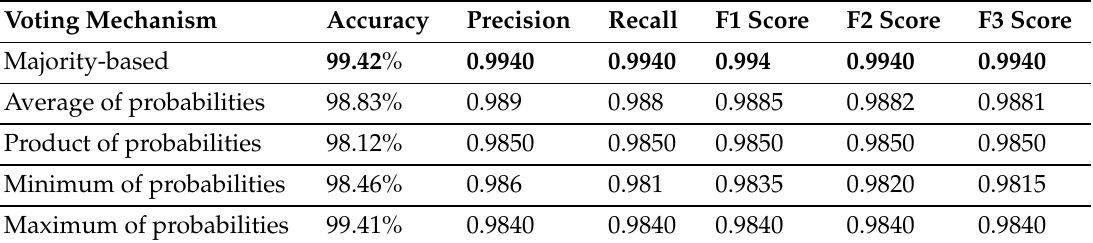
Table 3. Evaluation results of the proposed voting mechanisms for the WBCD.